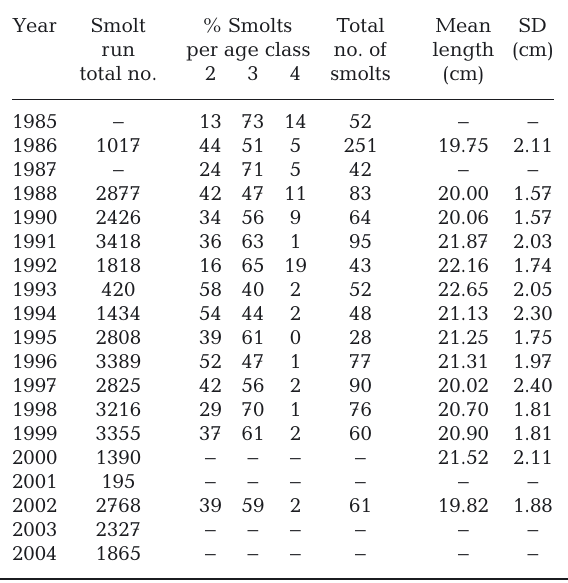
Table 3. Annual sea trout Salmo trutta smolt run, percentage smolt age composition and mean length of smolts with standard deviation (SD). –: no